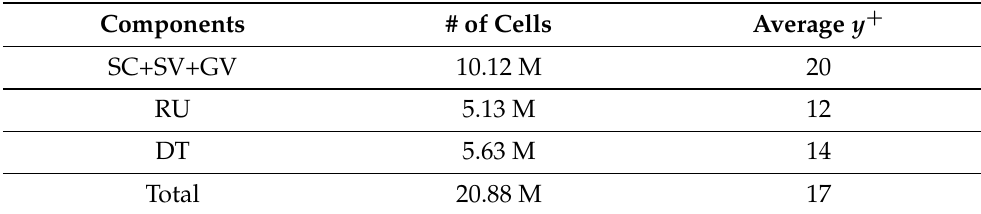
Figure 1. Computational domain and mesh in the runner and draft tube. Table 1. Mesh